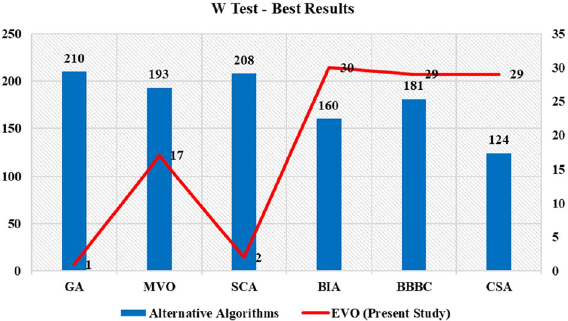
Figure 6. The W test results (mean of ranks) for different metaheuristic algorithms.